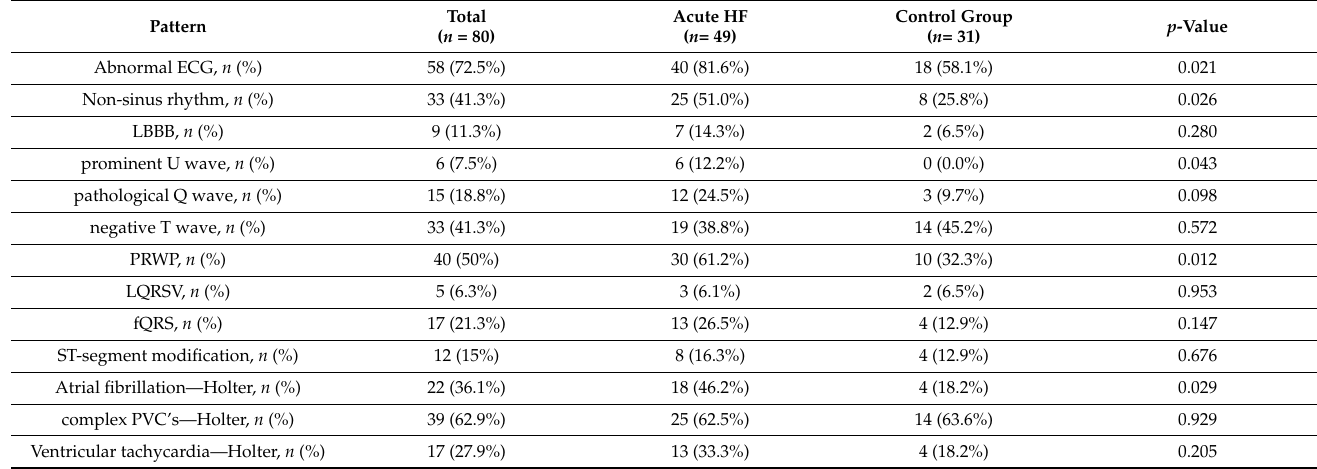
Table 9. Pathological patterns on ECG and Holter in AHF and control group.